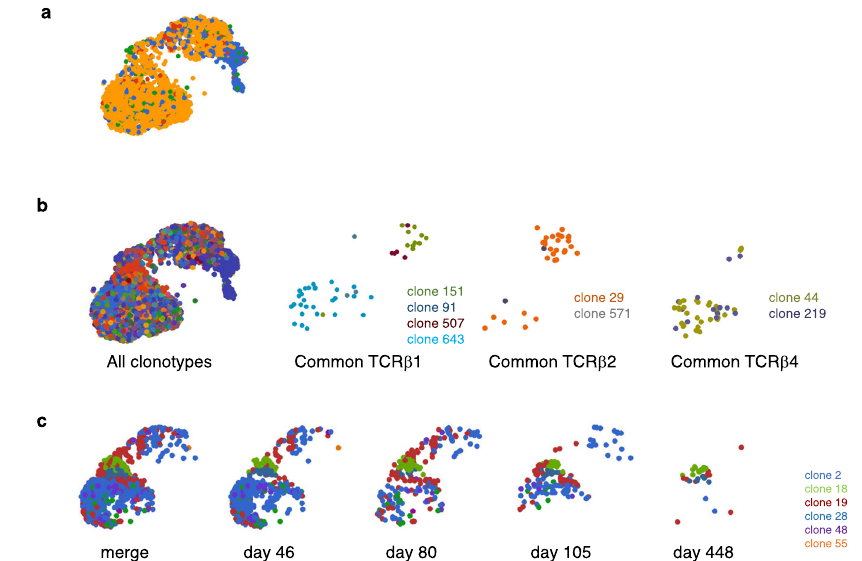
Fig. 6 | Single-cell TCR-sequencing of M 198 – 206 -speci fi c CD8+ T cells. a UMAP shows clonal expansion of M 198 – 206 -speci fi c CD8 + T cells. Each color indicate the numberofcellsobservedforeachclone.Yellow,threeormorecells;red,twocells; blue, single-cell; green, others. The cells from time-course study samples (Hashtag 2,3,4,and 6, see SupplementaryTable 3)wereomittedfrom the analysis. b EachT